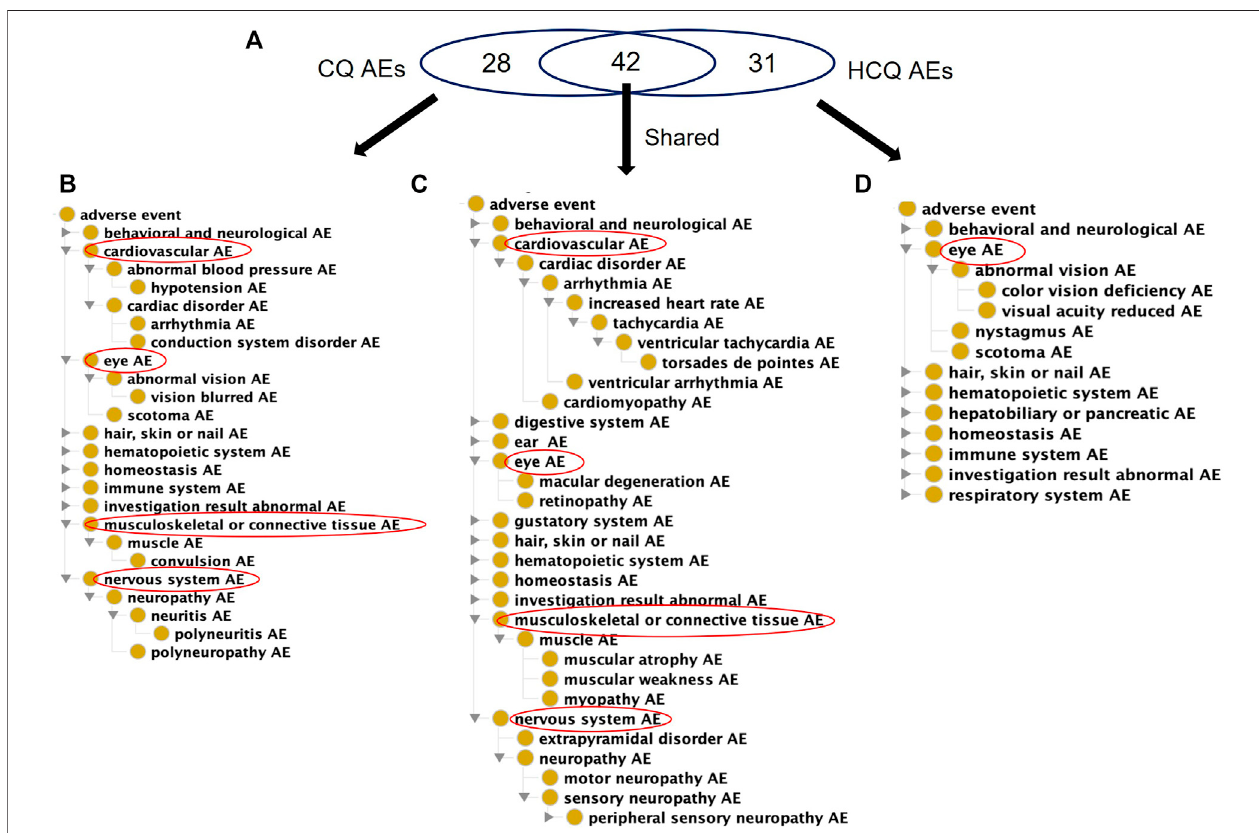
FIGURE2| Comparison ofUSPI-listed AEs associated withchloroquineand Hydroxychloroquineusing theOAE. (A) Venn Diagram ofCQand HCQ AEs. (B) OAE displayof28CQ-speci fi cAEs (C) OAEdisplayof42AEssharedbyCQandHCQ. (D) OAEdisplayof31AEsspeci fi ctoHCQ.Theseresultswereidenti fi edusingtheFDA USPrescribingInformation(USPI)data.Ineachpanelin (B,D) ,cardiovascularandeyeAEsareexpanded,ifpresentinthelist.OverallCQandHCQwereassociatedwith similar AE pro fi les, but HCQ had fewer types of severe cardiovascular, nervous, and musculoskeletal AEs.